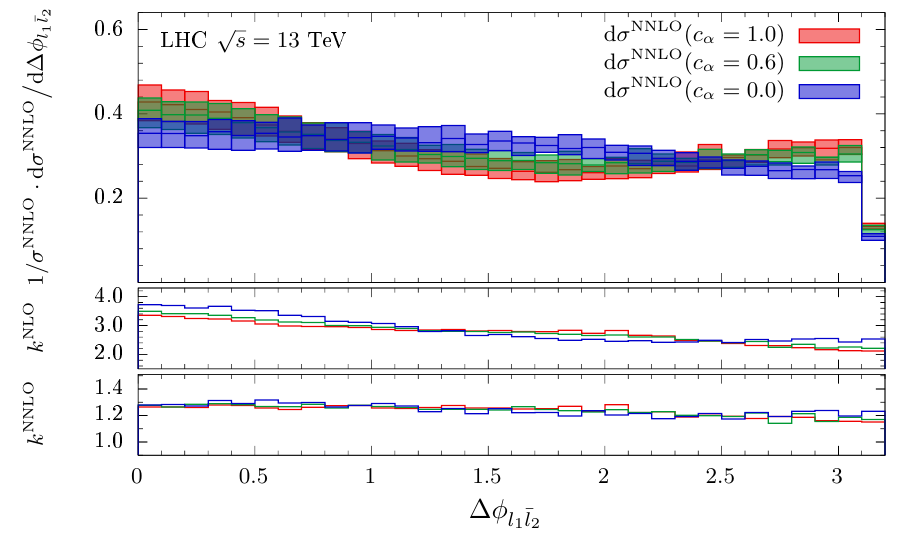
Figure 3 . Normalized distribution at NNLO accuracy and di(cid:11)erential k -factors d k NLO and d k NNLO for the (cid:1) (cid:30) observable. See text for further l 1 (cid:22) l 2